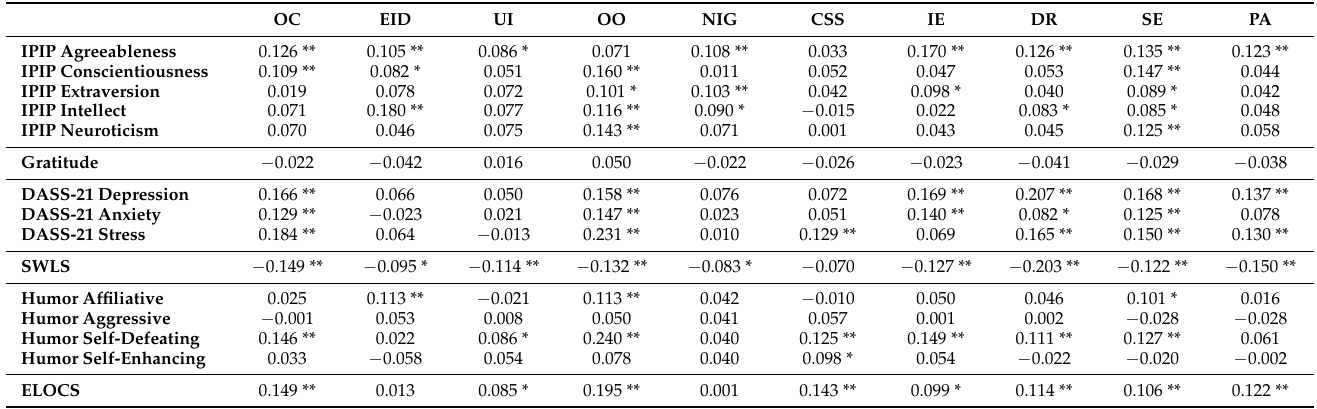
Table 7. Correlations between the YPI-R3 and IPIP, Gratitude, DASS-21, SWLS and Humor scales using the Singapore mothers’ sample ( n =